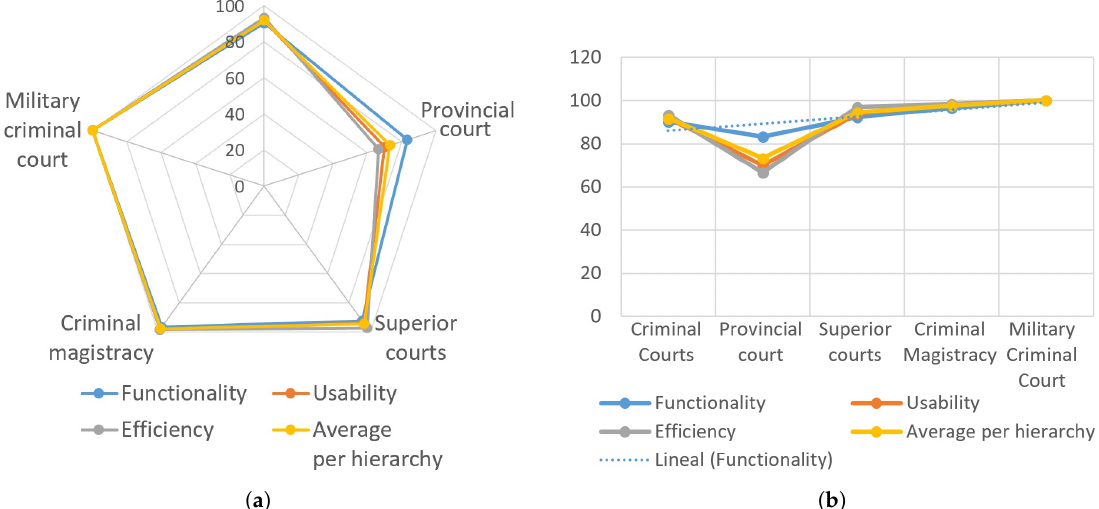
Figure 16. Characteristics evaluation score and acceptability trend. ( a ) Scoring radar on system by hierarchy. ( b ) RYEL acceptability tendency according to the hierarchy of the judges.